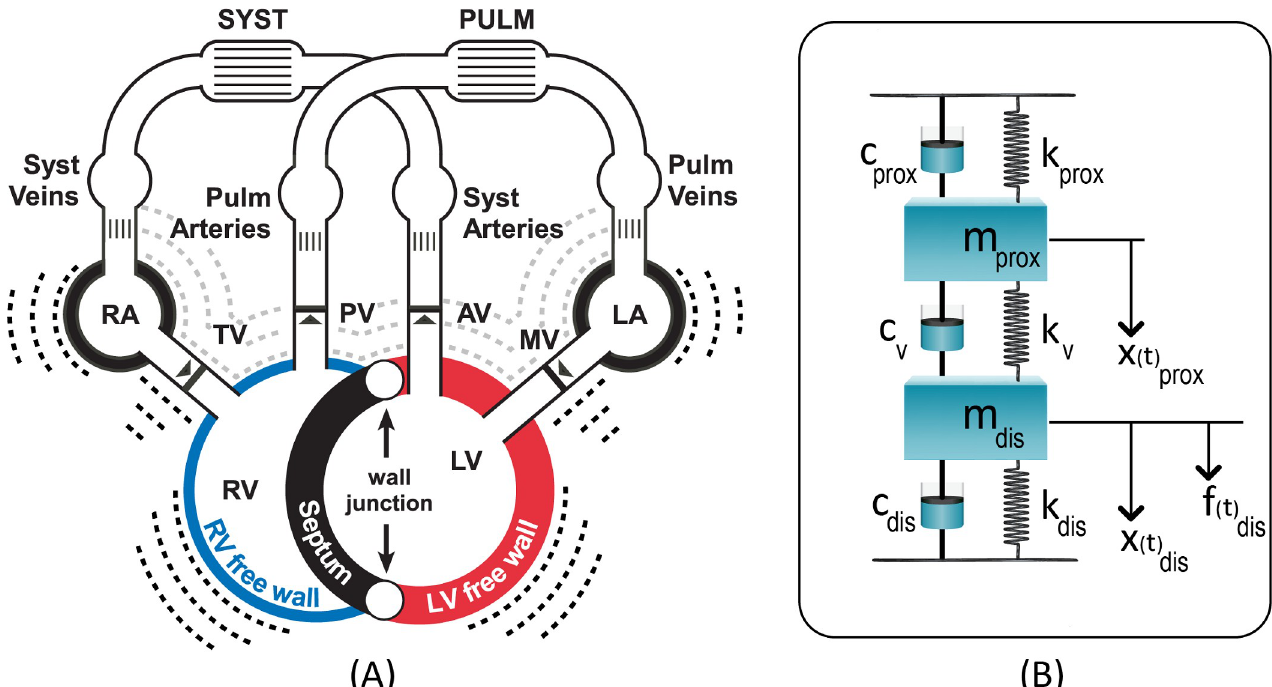
Fig 1. (a) CircAdapt model for simulation of cardiovascular mechanics and hemodynamics. (b) Two-degree- of-freedom model used for heart sound generation and embedded in CircAdapt. For each valve the same model was used albeit with different proximal and distal mechanical and hemodynamic values. Panel (a): LA : left atrium, LV : left ventricle, MV : mitral valve, PV : pulmonary valve, RA : right atrium, RV : right ventricle, TV : tricuspid valve. Panel (b): c : damping factor, dis : distal to valve, f : driving force, k : spring factor, m : blood mass, prox : proximal to valve, v : valve, x : movement of mass.